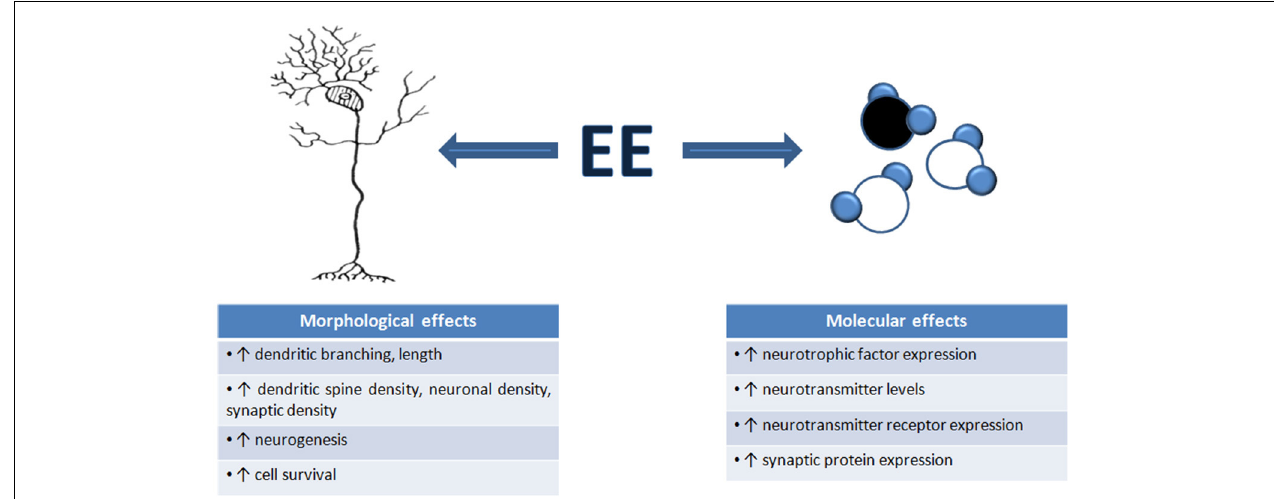
FIGURE 1 | Environmental enrichment induces morphological and molecular changes in the brain. An overview of the number of structural and molecular mechanisms that contribute to the changes in